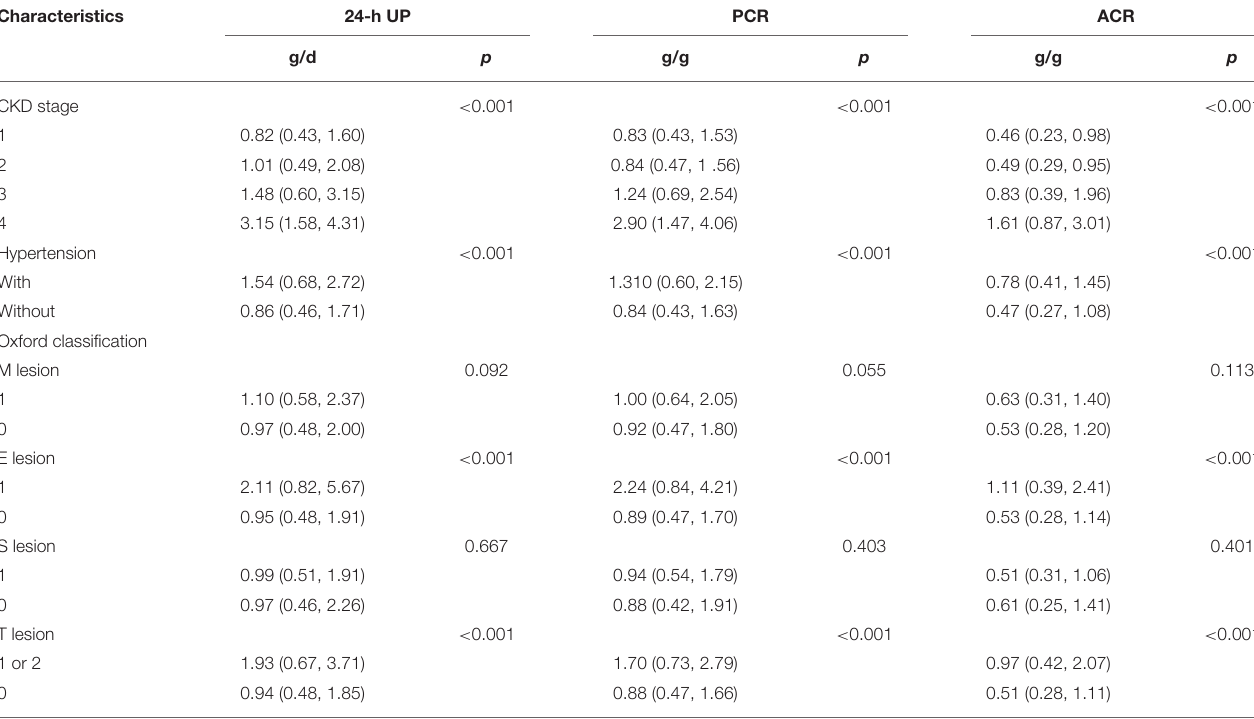
TABLE 2 | Correlation between 24-h urinary protein excretion (24-h UP), PCR, and ACR and severity of IgA nephropathy. Characteristics